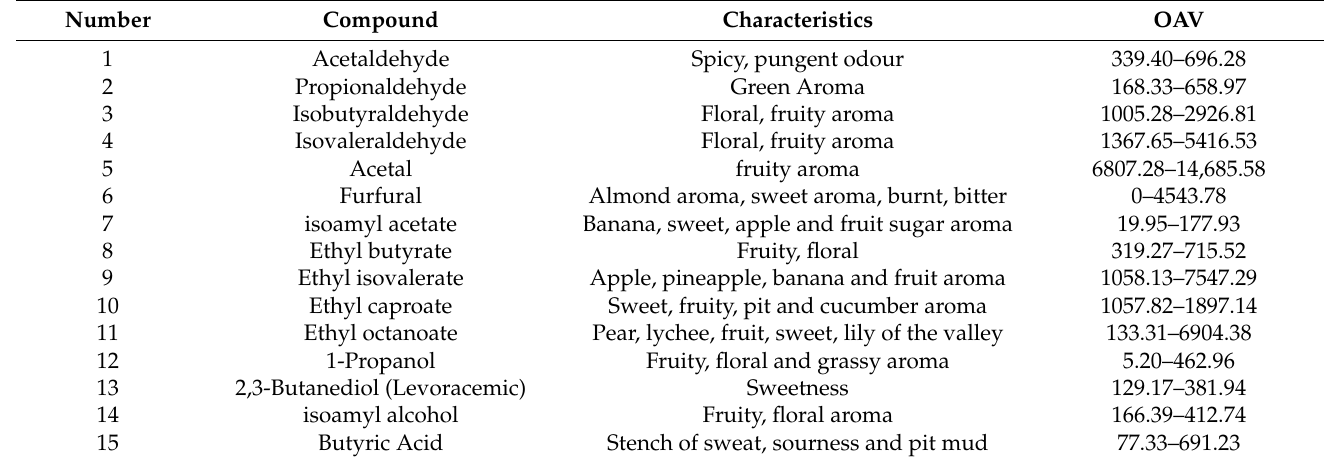
Table 4. The 15 flavor compounds and aroma in different rounds of base